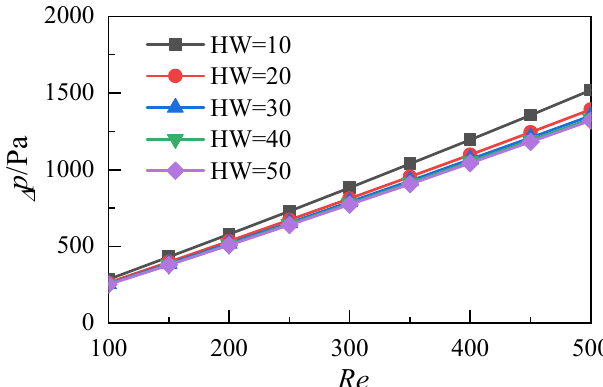
Figure 10. Distributions of pressure difference between the inlet and the outlet of the microchannel heat sink with different aspect ratios.